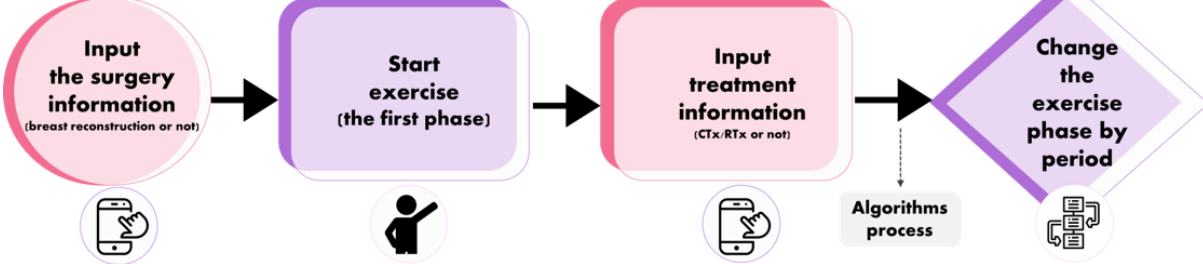
Aerobic Exercise for Breast